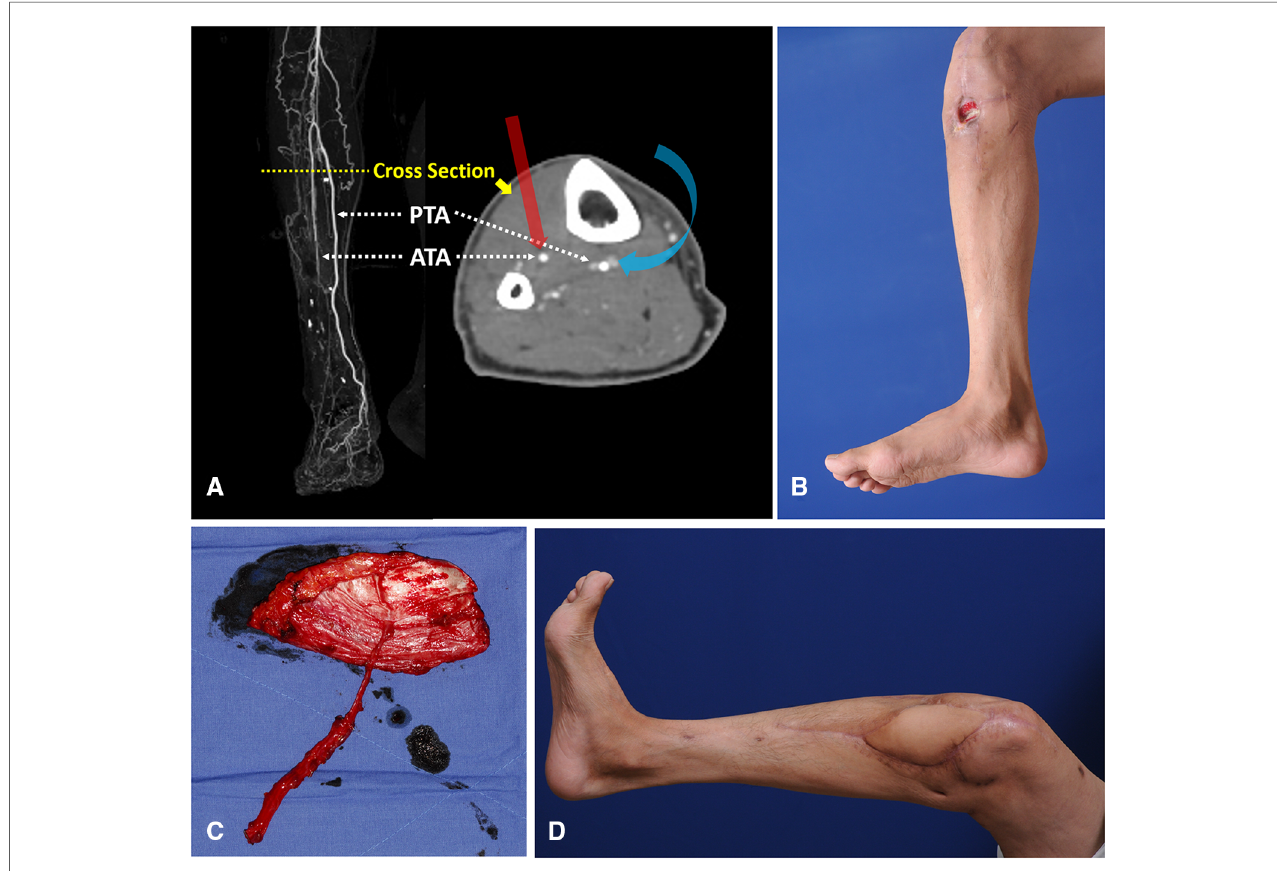
FIGURE 10 Reconstruction of soft-tissue defect around the knee by free transfer of Cen-ALTP fl ap using PTA and its concomitant veins as recipient vessels (Case No.2; Algorithmic option No.5) ( A ) Generally, when the defect center was below the patella center, ATA was fi rst considered a recipient artery for the free fl ap coverage of the defect because of its ease of accessibility compared to PTA. Because PTA is located posterior to the tibia bone in the deep posterior muscle compartment, the approach to PTA in the proximal third of the calf is very hard. However, in cases where ATA is unavailable to use due to traumatic injuries or limited accessibility, PTA could be alternatively used as recipient vessel, just like in this case (The red arrow indicates straightforward access to ATA; the Blue arrow indicates tricky access to PTA). ( B ) A chronic wound was observed in a 46-year-old male patient with osteomyelitis of the knee joint. The wound center was below the patella center, and the proximal end of the defect after debridement was presumed to be below the patella center. ( C ) Because the defect size was relatively small, Cen-ALTP fl ap with small round skin paddle (13×10 cm 2 ) was harvested. To achieve tension-free anastomosis, a long pedicle was included the fl ap. The fl ap pedicle was anastomosed to PTA and its concomitant veins without vein graft. ( D ) Result 5 months postoperatively. (Cen-ALTP fl ap, anterolateral thigh perforator fl ap with centrally located perforators; PTA, posterior tibial artery; ATA, anterior tibial